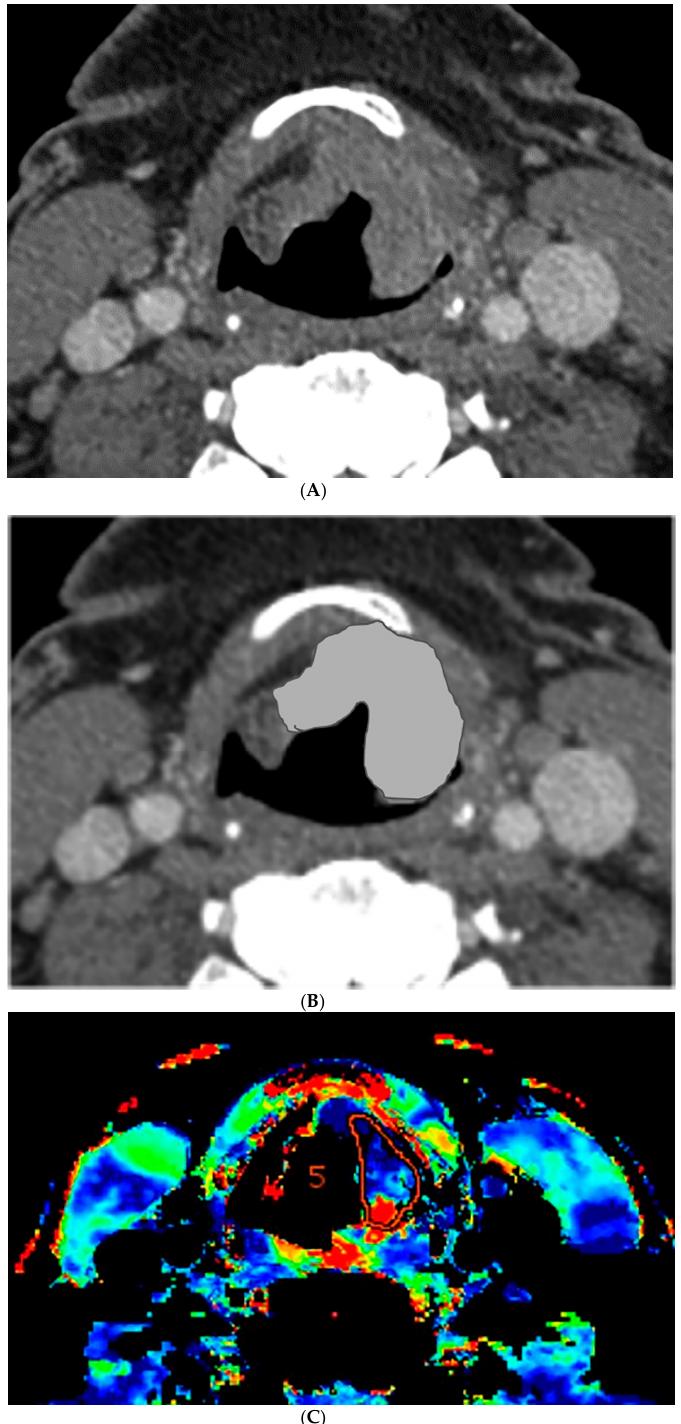
Figure 1. Computer tomography (CT) and perfusion sections of laryngeal carcinoma on pre-treatment images. Axial sections show the grayscale image ( A ) and outlines for the following: computer ( B ) and perfusion image ( C ). Note that the region of interest (ROI) drawn on the CT perfusion image appears different in size from that on the contrast enhanced image; this is because the CT perfusion images are 5 mm in slice thickness whereas the conventional CT images are 1.25 mm in slice thickness (implying that the CT perfusion data is a composite of 4 adjacent 1.25 mm slices from conventional CT).